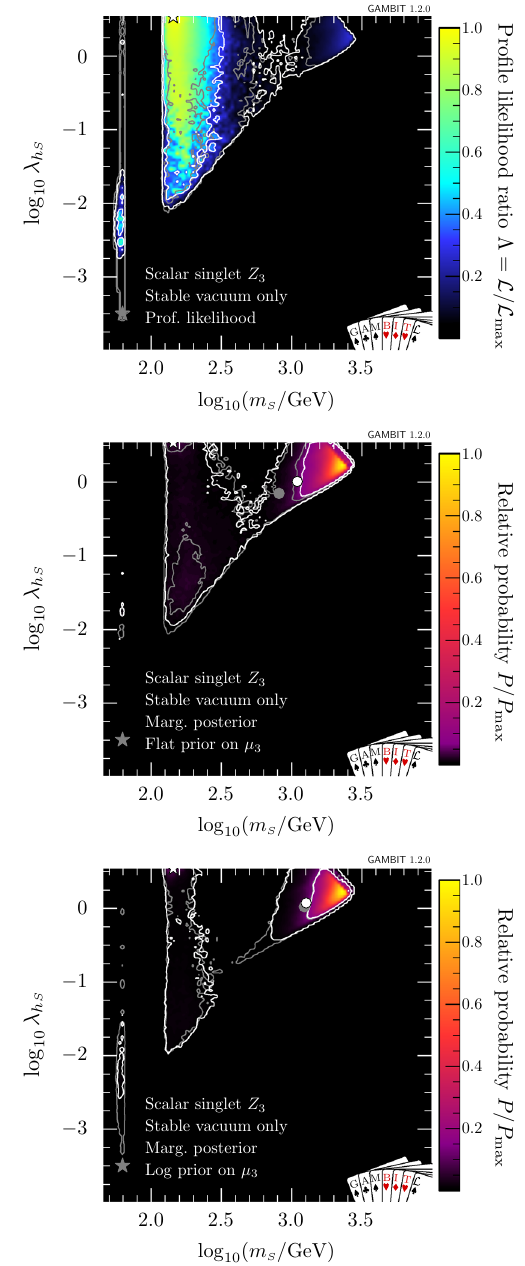
Fig. 11 Impact of the requirement of vacuum stability on the Z 3 scalar singlet model, expressed in terms of profile likelihoods (top) and pos- terior probability densities with flat prior on μ 3 (centre) and with log- arithmic prior on μ 3 (bottom). Bullets indicate posterior means and stars indicate best fit points. Shading and white annotations correspond to scans where the singlet is required to absolutely stabilise the elec- troweak vacuum. For comparison, we also show the preferred regions without this requirement in grey